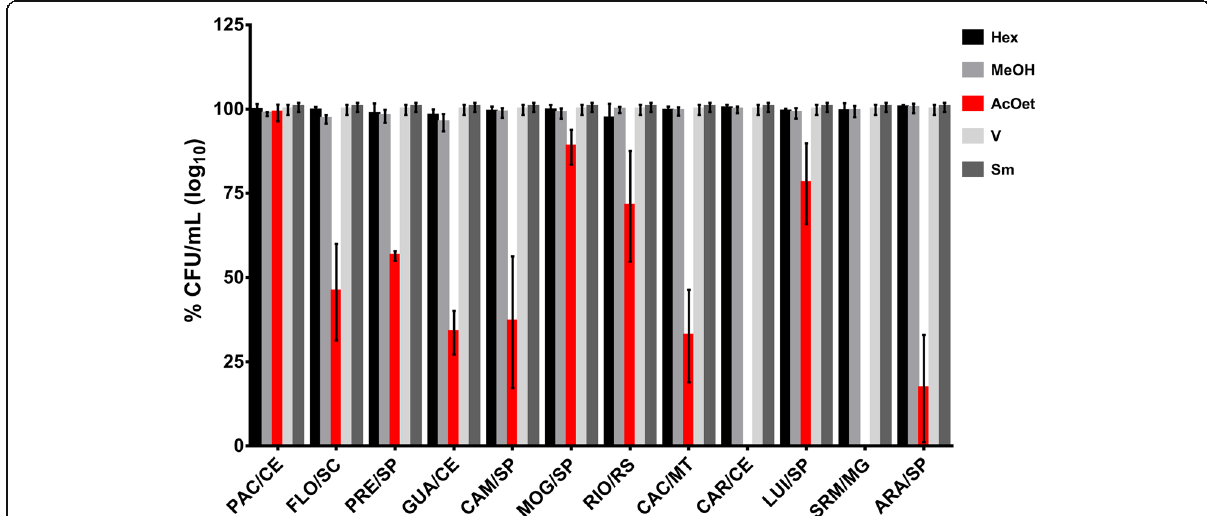
Fig. 3 Antimicrobial activity of three distinct fractions C. sylvestris from distinct Brazilian biomes against S. mutans . Data depicted are average and standard deviation. There was statistically significant difference between fraction AcOEt versus vehicle (V) control for all, except PAC/CE ( p ≤ 0.0001; two-way ANOVA between the bioma and fraction factors showed that the interaction between the factors is significant by factor p < 0.0001; biome p < 0.0001 and fraction p < 0.0001, followed by the Tukey multiple comparisons test; p > 0.050)